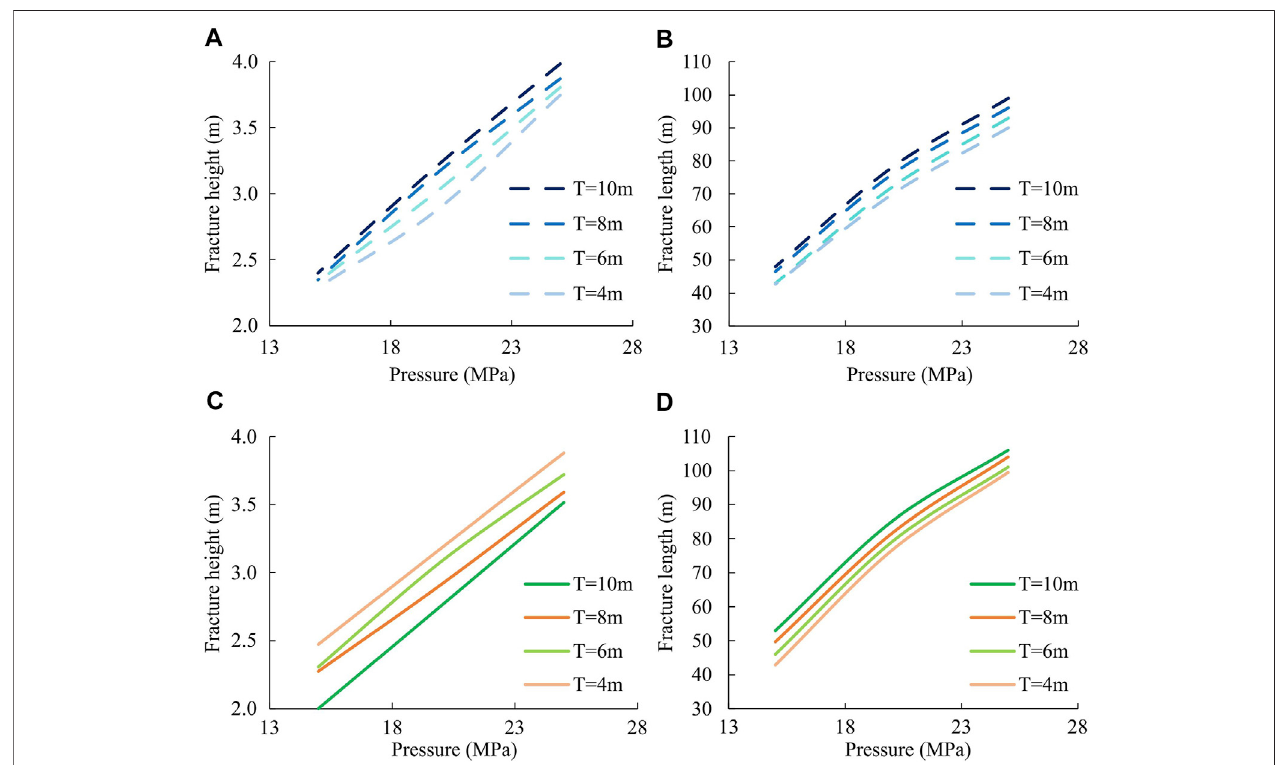
FIGURE12| FractureparametersunderdifferentthicknessesofNo.13coalseam. (A) ThefractureheightoftheNo.9coalseam. (B) ThefracturelengthoftheNo. 9 coal seam. (C) The fracture height of No. 13 coal seam. (D) The fracture length of the No. 13 coal seam.